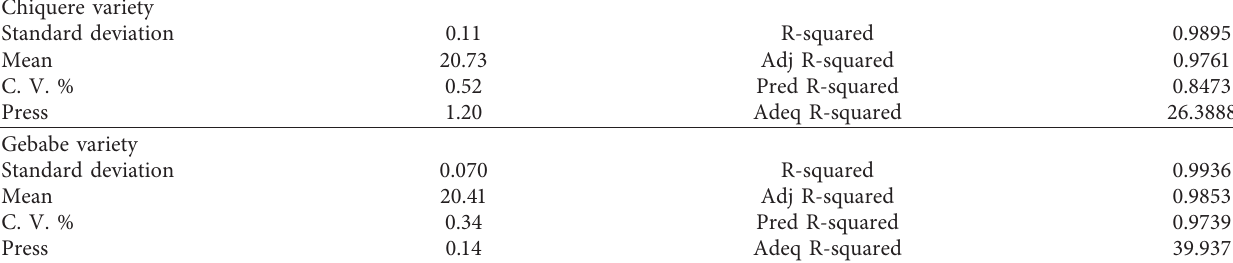
Table 5: Model adequacy measures of Chiquere and Gebabe variety ethanol yield of sweet sorghum. Chiquere